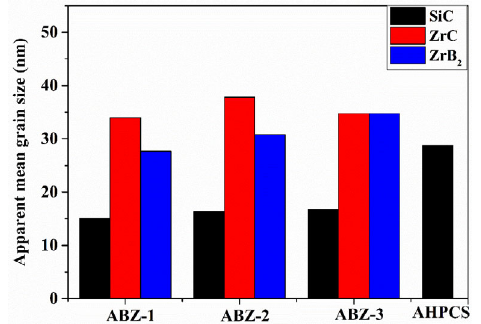
Fig. 7 Apparent mean grain size of 1600 ℃ ceramics derived from single-source precursor and from AHPCS.